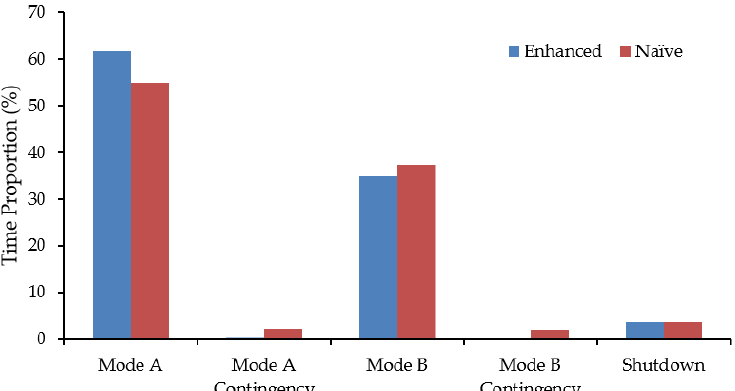
Figure 11. Histogram showing the relative modal time proportions of the final enhanced model vs. a naïve model that uses the deterministic values for critical RTO (2700 t) and target total ore (5940 t) levels over 100 replications.